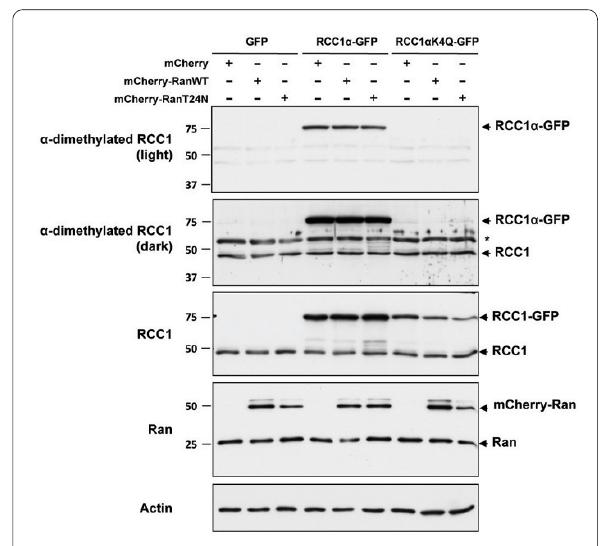
Figure 4 α-N-terminal methylation of RCC1α is not affected by the stable association of Ran . U2OS cells were co-transfected with GFP, RCC1α-GFP or RCC1α K4Q -GFP and mCherry, mCherry-Ran WT or mCherry-Ran T24N . Cell lysates were analysed by Western blotting for α- dimethylated RCC1, RCC1, Ran and actin as a loading control. Methy- lated RCC1α-GFP was revealed on a light exposure of the α-dimethy- lated RCC1 blot and endogenous RCC1 isoforms on a dark exposure. A non-specific reactive band noted by [18] is indicated by *. The migra- tion position of molecular mass markers (kDa) are shown